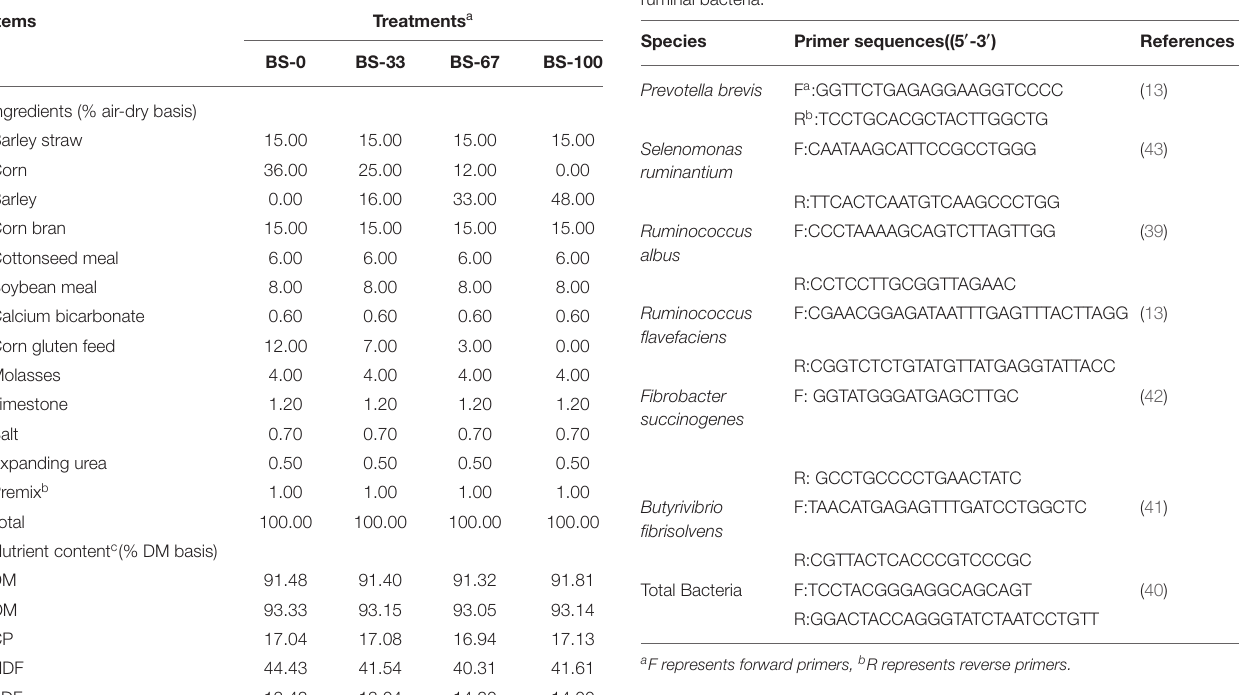
TABLE 1 | Ingredients and nutrient levels of experimental diets. TABLE 2 | Primers used for quantitative real time-PCR amplification primer of